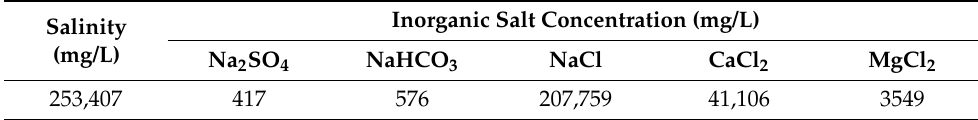
Table 1. Inorganic salt compositions of simulated water from Tahe Oilfield.